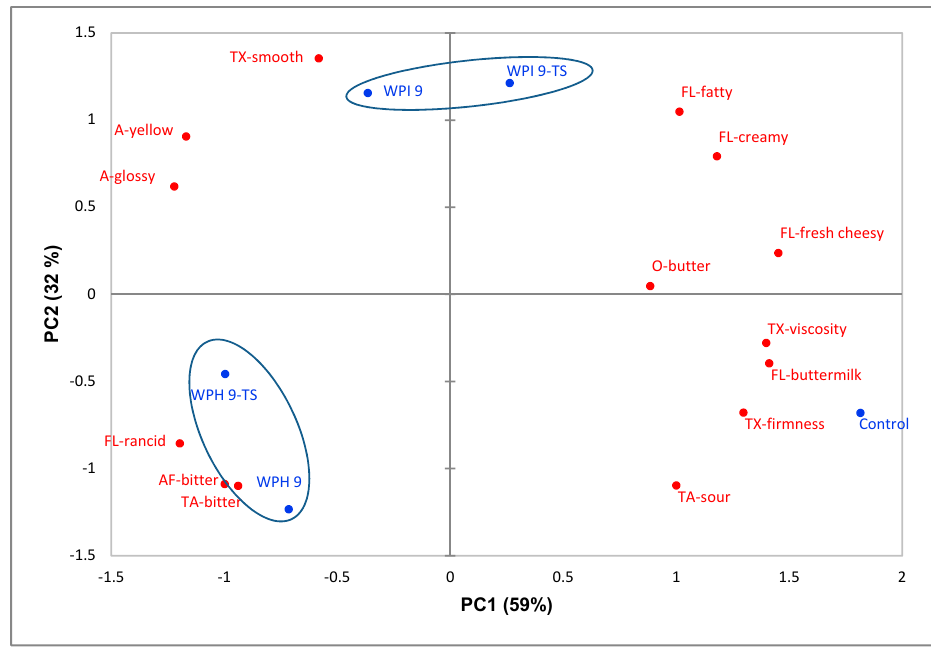
Figure 4. Principal components analysis bi ‐ plot of sensory attributes (red labels) and cream cheese samples (blue labels). Blue labels: numbers indicate amount of added protein (9 = 9%); TS = texture and taste ‐ modified samples. Red labels: O = odor attributes; A = appearance attributes; TA = taste attributes; TX = texture attributes; FL = flavor attributes; AF = aftertaste attributes.